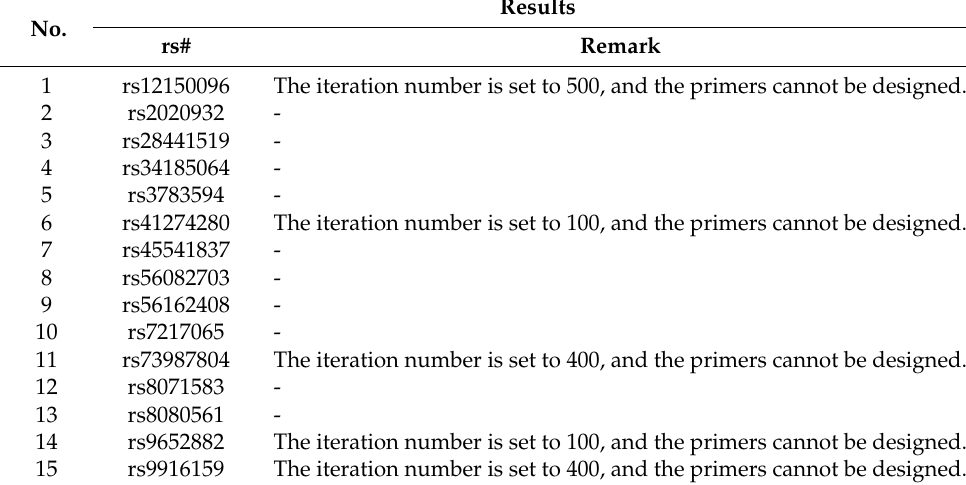
Table 1. Fifteen mismatch PCR-RFLP SNPs in the SLC6A4